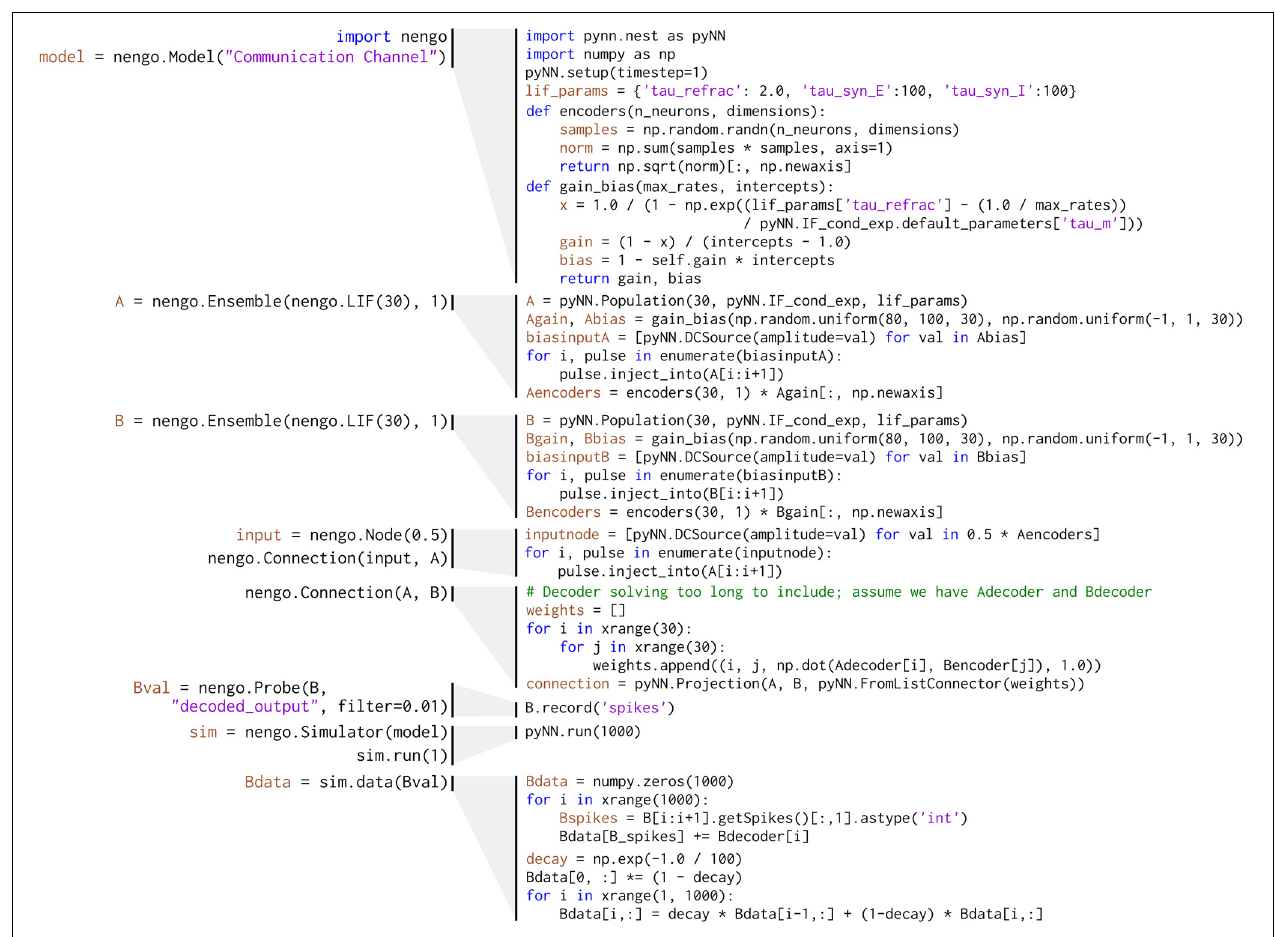
FIGURE 4 | Implementation of the communication channel (left) in Nengo and (right) in PyNN. Solving for decoding weights takes approximately 40 lines of code, which are not included in this figure.